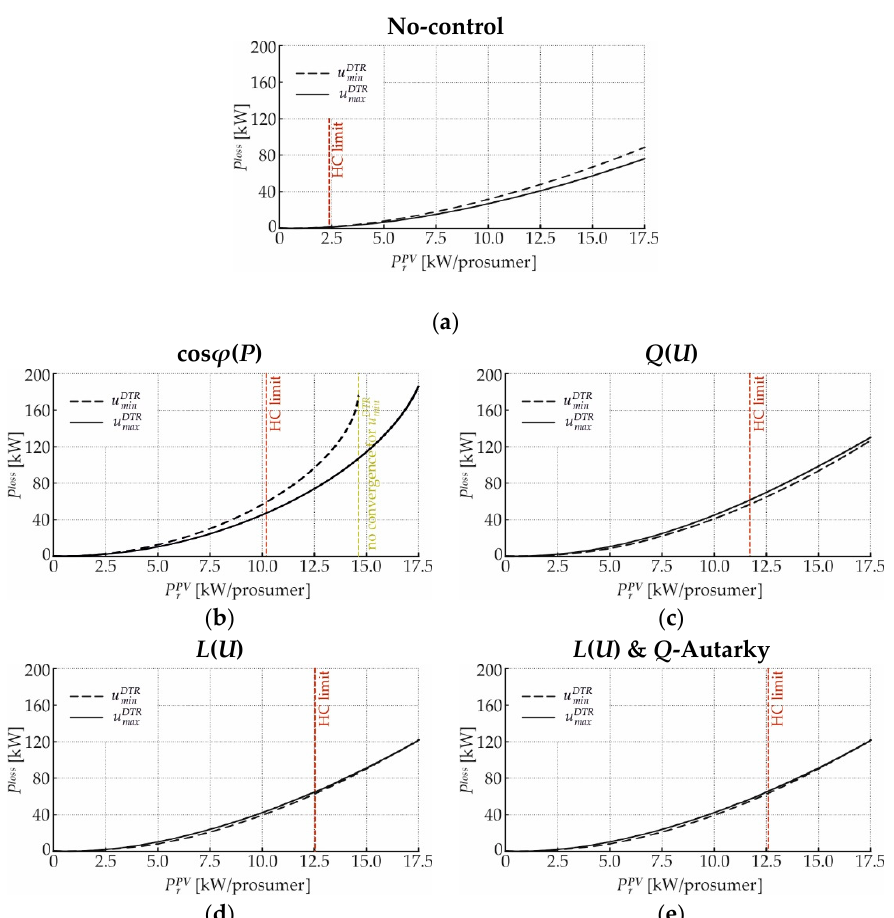
Figure 8. Grid losses of the long overhead line test-feeder for the minimal and maximal DTR primary voltages and different control strategies: ( a ) no-control; ( b ) cos φ ( P )-control; ( c ) Q ( U )-control; ( d ) L ( U )-control; ( e ) L ( U )-control and Q -Autarkic prosumers.